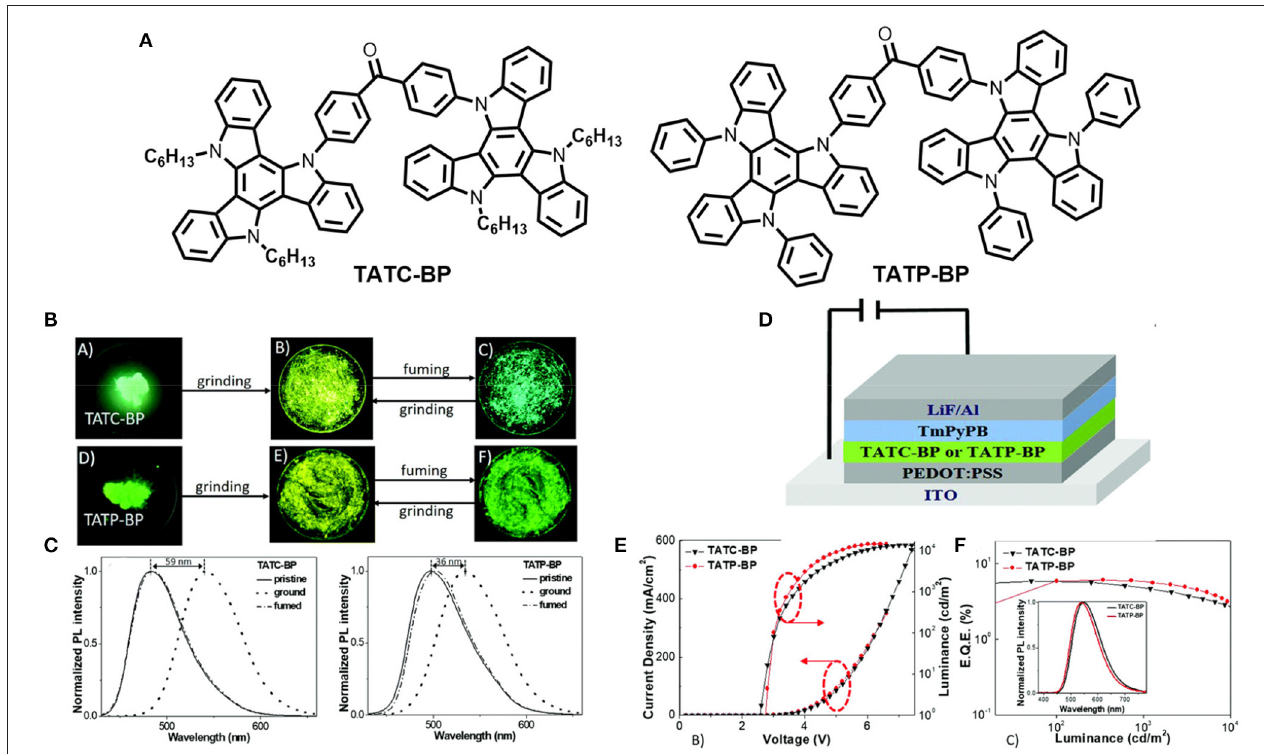
FIGURE 10 | (A) Molecular structures of TATC-BP and TATP-BP (B) Luminescence images (under 365 UV-lamp) of the pristine crystalline, ground, and vapor fumed powders of the emitters. (C) Normalized MCL PL spectra of the emitters. Device configuration. (D) J-V-L graph (E) EQE and EL characteristics. Inset: EL spectra of the OLED devices at 1,000cd m- 2 . Reproduced with permission from Chen et al. (2018). Copyright © The Royal Society of Chemistry.